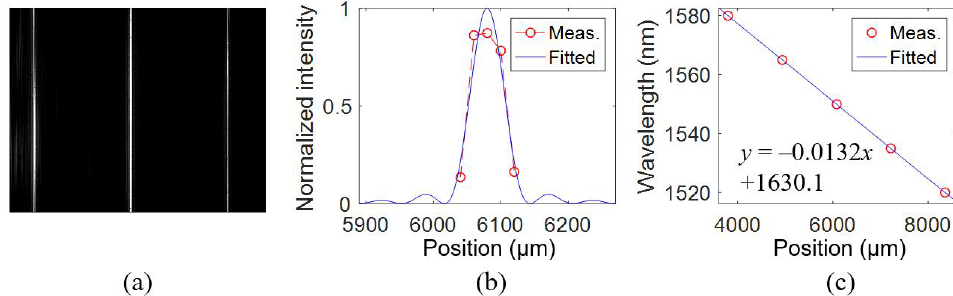
Figure 10. Measured results of WSL1 with a focal length of 5 cm. ( a ) Spectral lines at 1550 nm. ( b ) Measured and fitted far-field distributions with an FWHM of 0.74 nm at 1550 nm. ( c ) Measured and fitted wavelengths at different pixel positions.